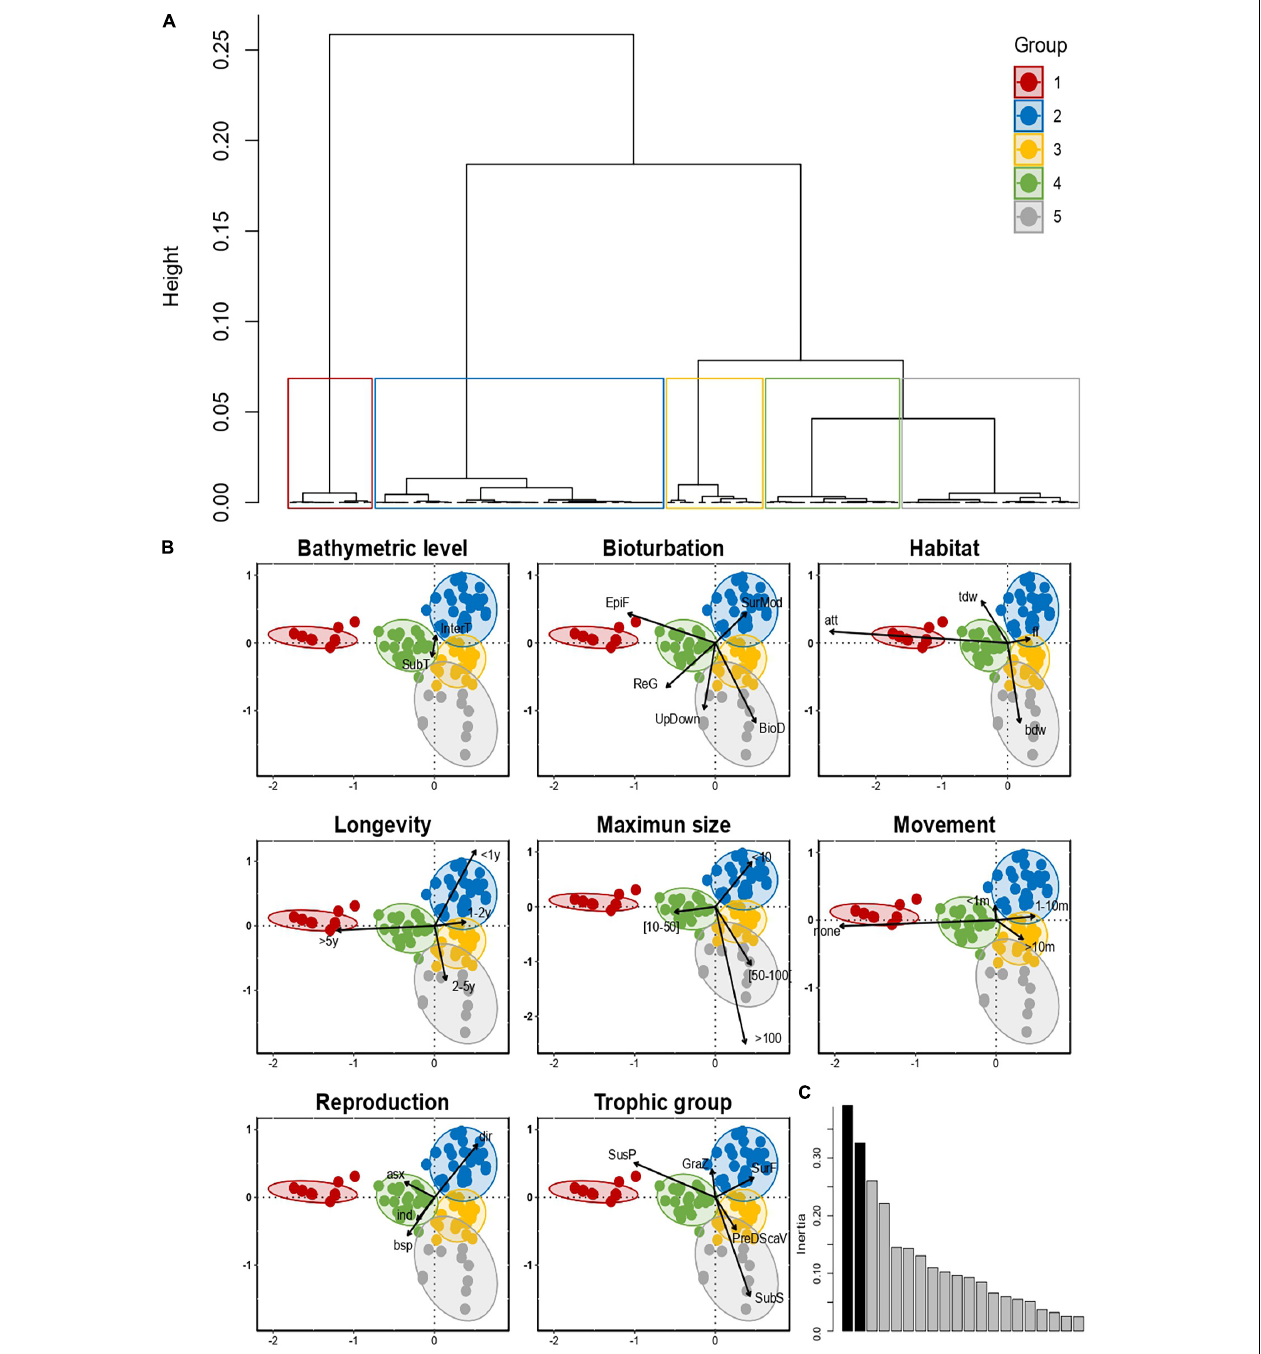
FIGURE 4 | (A) Cluster constructed using the “Ward D2”’ method performed from the Fuzzy Correspondence Analysis (FCA) results. (B) Projection of modalities and taxa by biological traits on the first two axes of the FCA. (C) Histogram of eigenvalues. The first two axes (in black) were kept in the FCA.